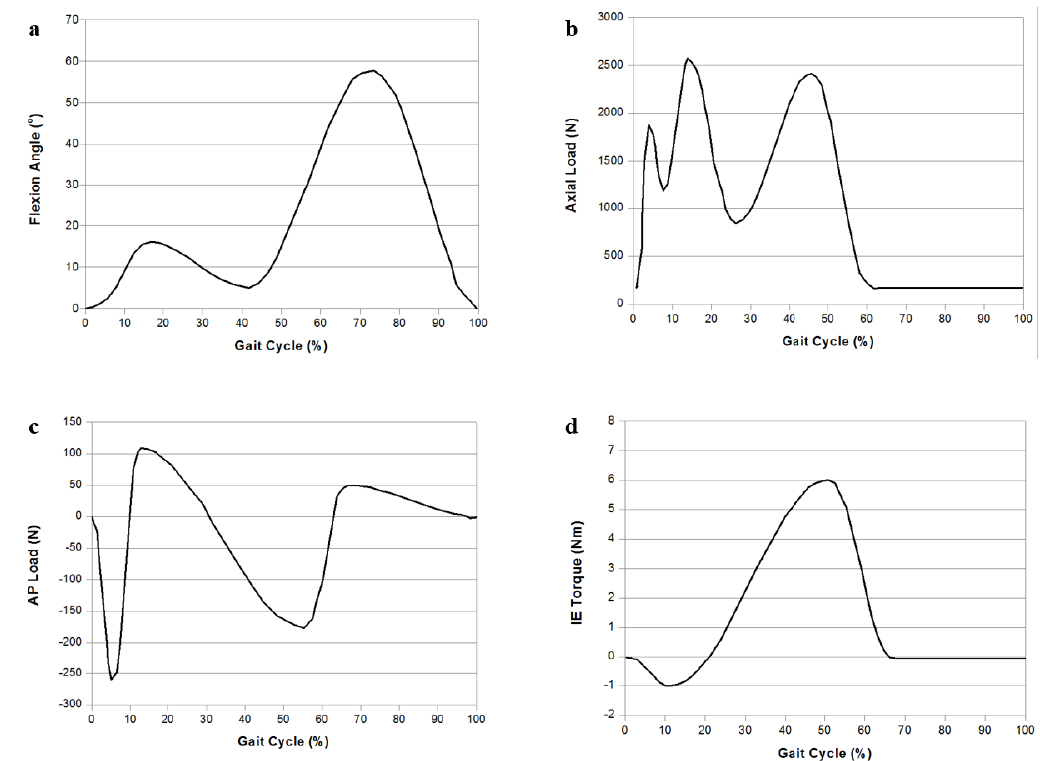
Figure 2. Input function of the gait cycle applied in the study: ( a ) flexion angle; ( b ) axial load, ( c ) anterior-posterior (AP) load; ( d ) internal-external (IE) torque.